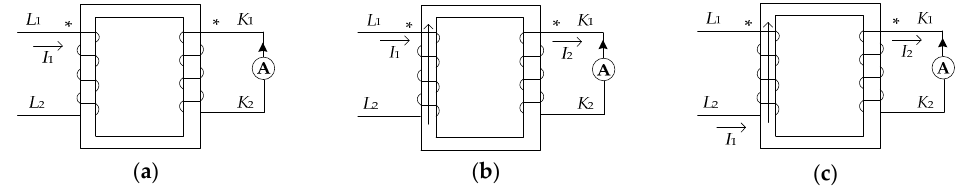
Figure 4. Current direction acquisition diagram: ( a ) Normal operation; ( b ) I 1 decreases rapidly; ( c ) I 1 increases rapidly.